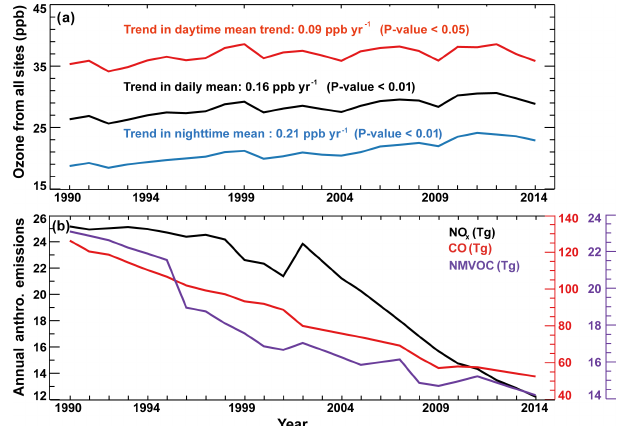
Figure 4. Long-term trends in the observed surface ozone and anthropogenic precursor emissions over the US during 1990– 2014. (a) The ozone trend averaged over the 124 grid cells. (b) The US annual anthropogenic (fossil + biofuel) emissions of NO x (black line), CO (red line), and NMVOC (purple line) from the National Emissions Inventory (http://www.epa.gov/